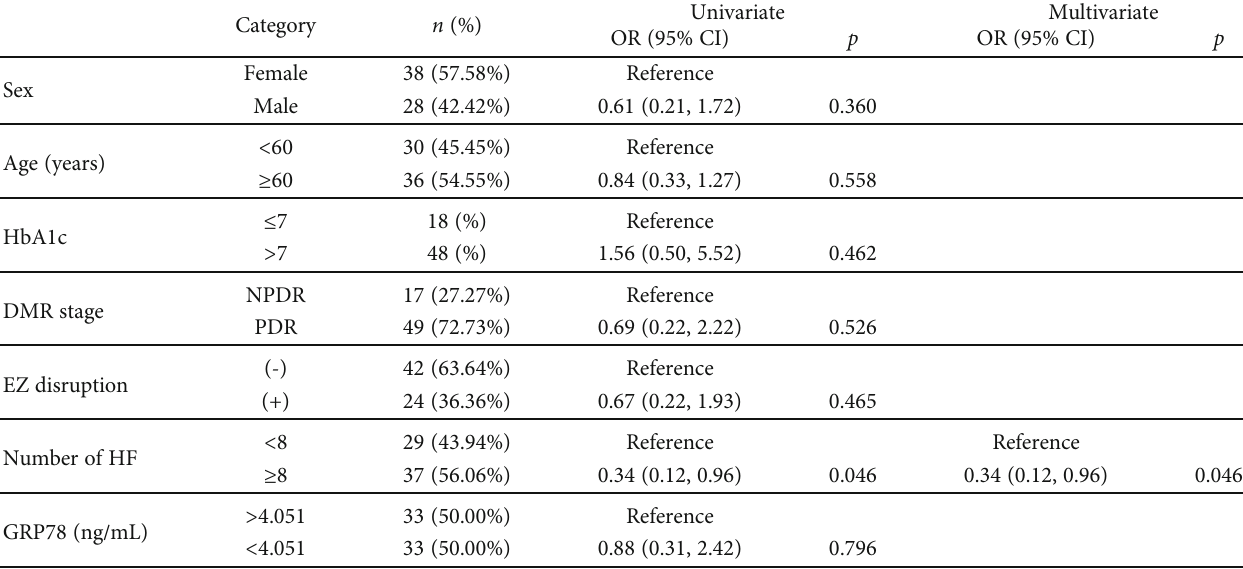
Table 3: Results of logistic regression, e ff ect on responsiveness to intravitreal bevacizumab